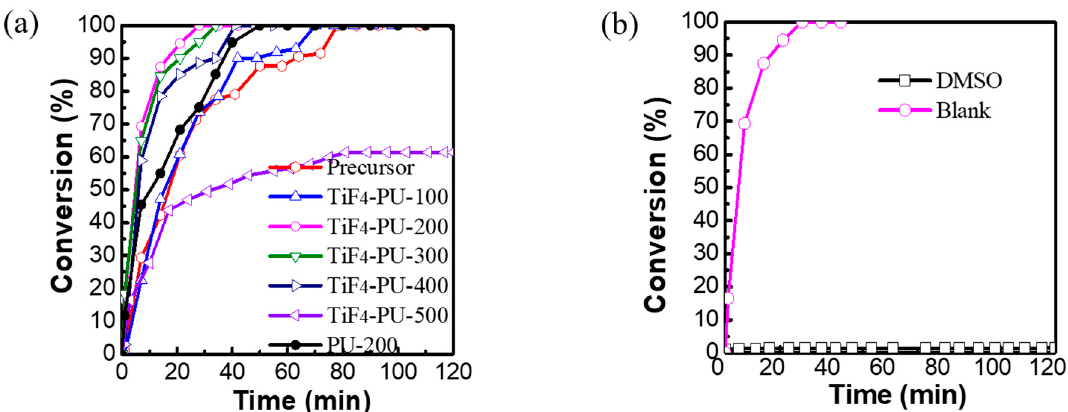
Figure 5. ( a ) ODS (oxidative desulfurization) activities over the TiF 4 -PU catalysts calcined at different reaction temperatures; ( b ) the inhibition effect of DMSO (Dimethyl sulfoxide) on the ODS reaction over the TiF 4 -PU-200 catalyst.